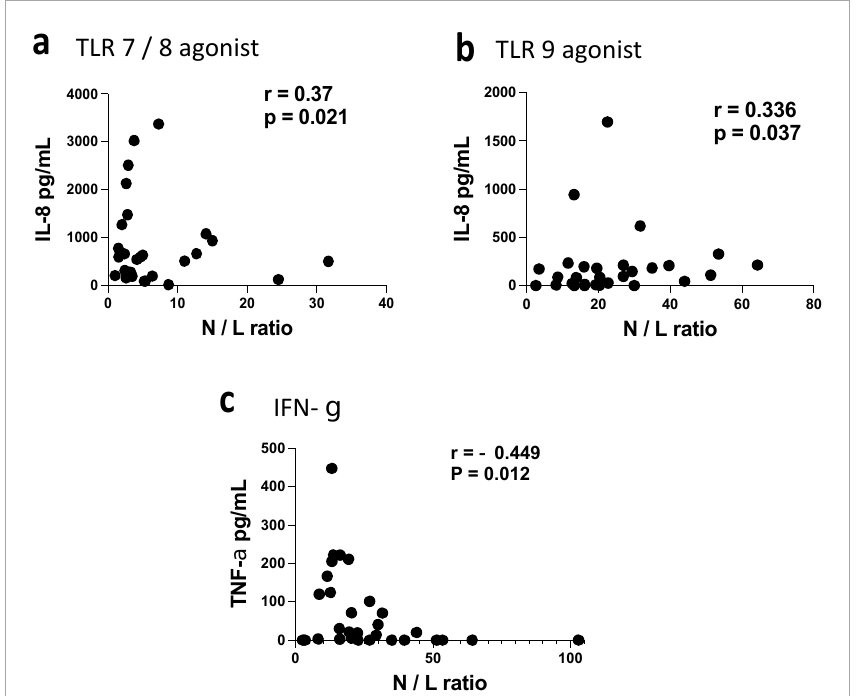
Figure 5. Correlation between cytokines production by agonist stimulation or IFN-γ stimulation vs. N/L ratio in COVID-19 patients. Dot plot of TLR7/8 and TLR9 receptor responses (secreting IL8) vs. N/L ratio ( a , b ), and IFN-γ receptor response (secreting TNF-α) vs. N/L ratio ( c ).